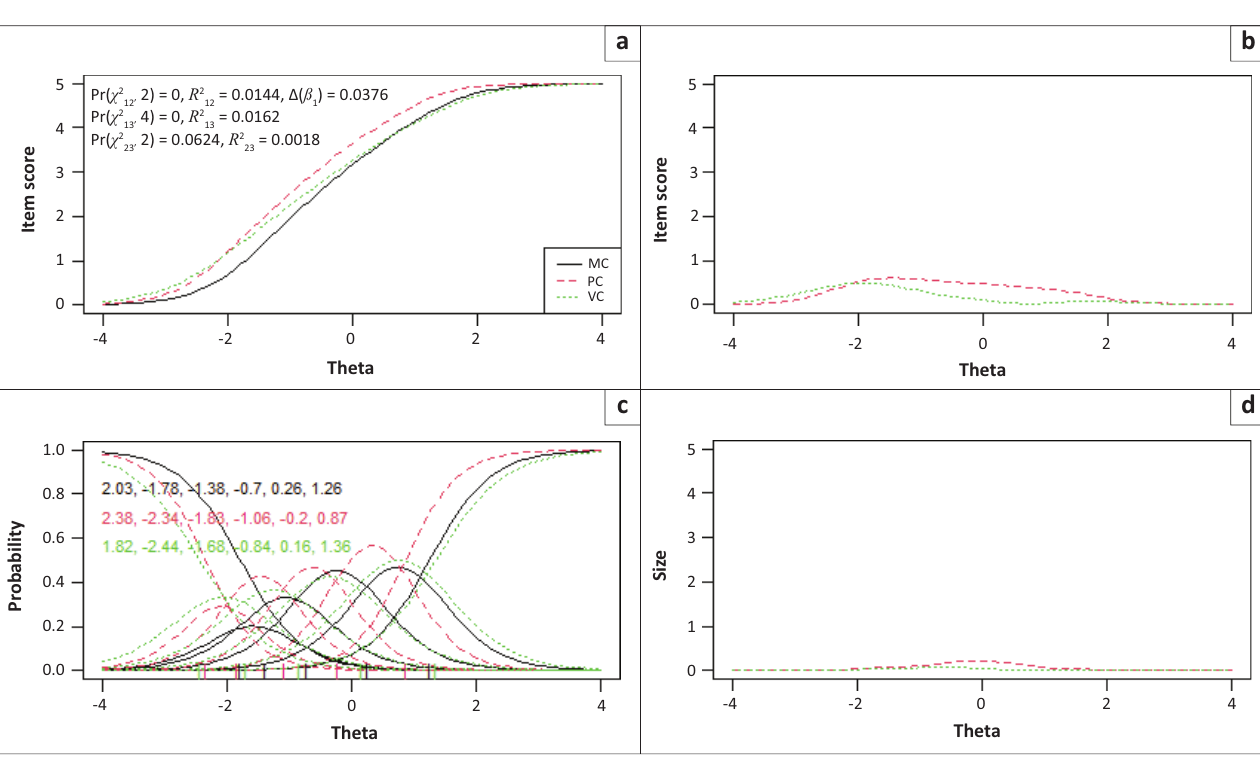
FIGURE 5: Graphical display of Item 3, which shows uniform and non-uniform differential item functioning with respect to campuses. (a) Items True Score Functions - item 3; (b) differences in items True Score Functions; (c) Item Response Functions; (d) Impact (weighed by density).